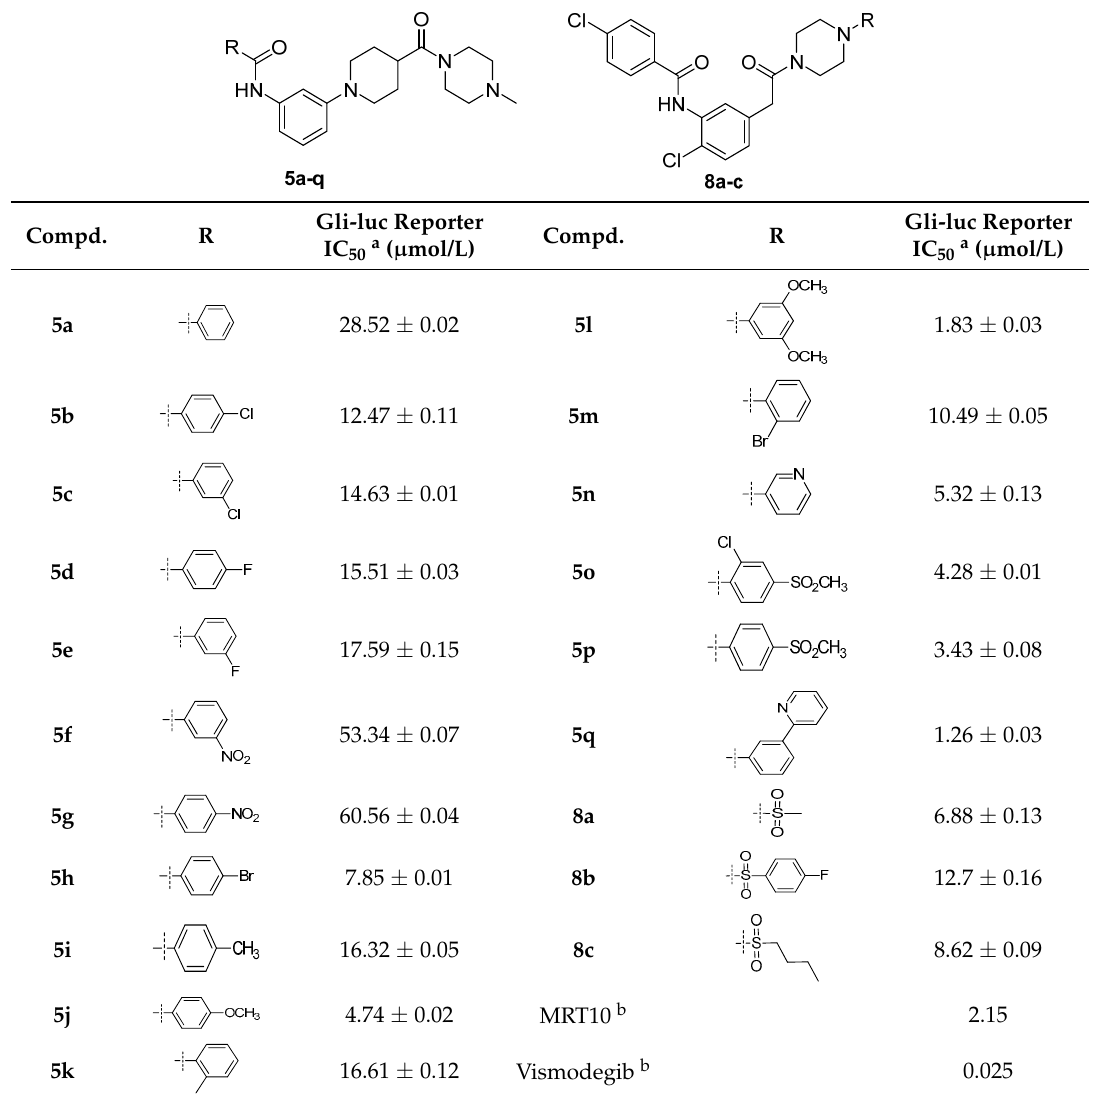
Table 1. The structures and the hedgehog pathway inhibition of target compounds.